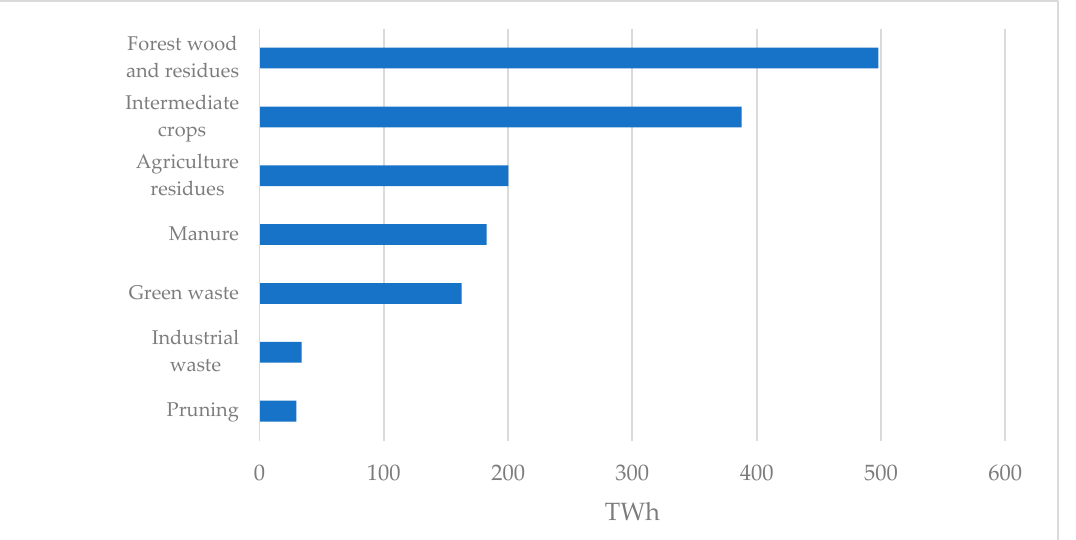
Figure 9. Structure of theoretical potential of biomethane production from various categories of bi- omass in EU(+UK) in perspective 2050. Source: own elaboration based on Birman et al. [69]. According to ENGIE analyses [69], the most important source of bio-mass production potential in the EU and UK should be seen in the perspective of 2050 in forest wood and residues (almost 500 TWh, 51.6 bcm), intermediate crops (nearly 390 TWh, 39.9 bcm), ag- ricultural residues (about 200 TWh, 20.5 bcm), manure (over 180 TWh, 18.42 bcm), and green waste (165 TWh, 16.9 bcm) [69] (Figure 10). It should be emphasized that the pre- sented estimates do not include energy crops because, according to the RED II Directive, biomass for sustainable biogas production should not create competition for agricultural land devoted to food and feed production. In 2010–2015, nearly half of the newly installed biomethane plants were based on Energy crops [82].